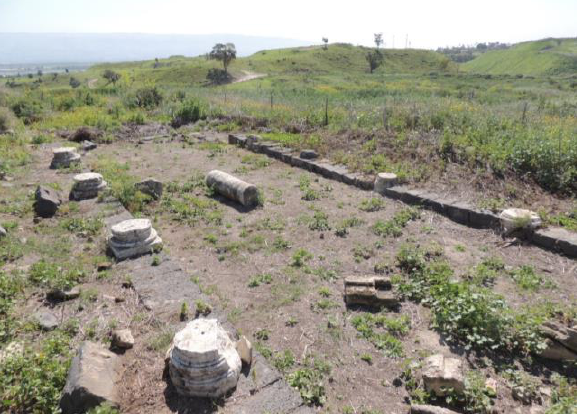
Figure 5. Bet She'an, Tel Iztabba synagogue, type D. (Photo: Y. Alef, 2017 ©